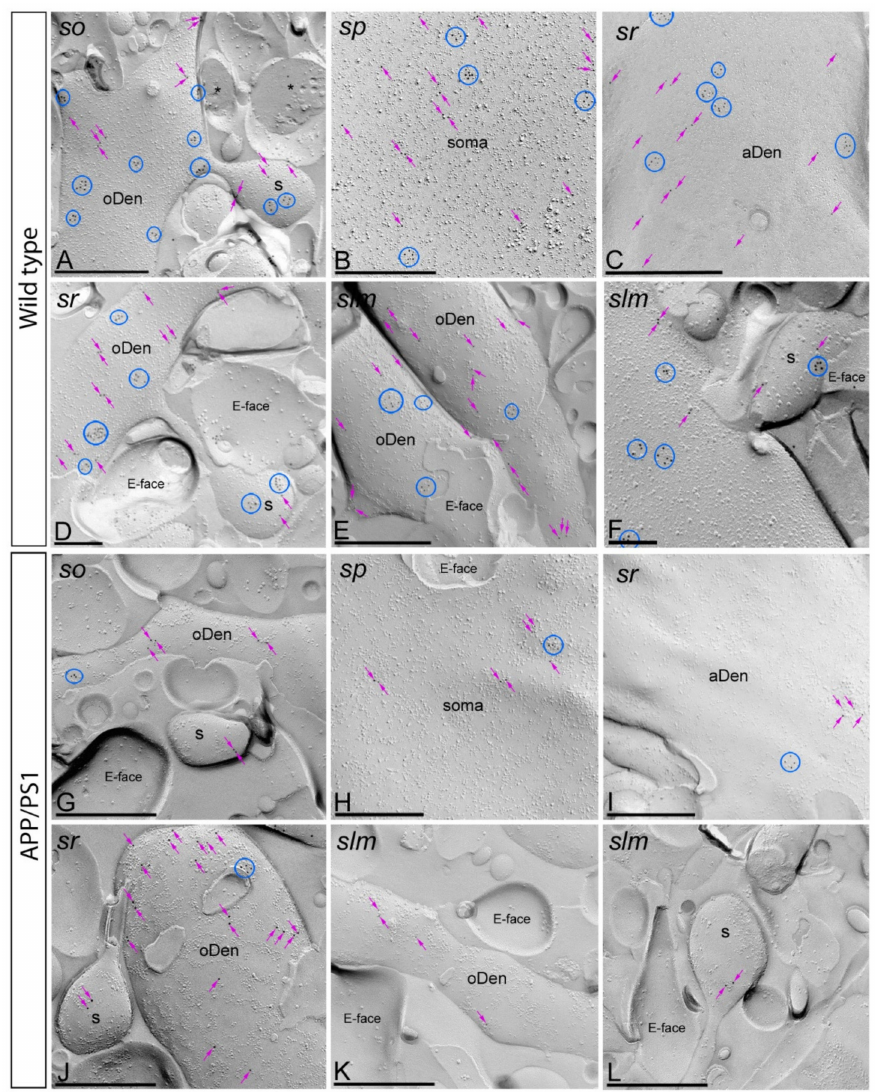
Figure 2. Subcellular localisation of mGlu 5 in somato-dendritic domains of CA1 pyramidal cells in wild type and APP/PS1 mice. ( A – F ) Electron micrographs obtained from different subfields of the CA1 region showing immunoparticles for mGlu 5 along the surface of pyramidal cells, as detected using the SDS-FRL technique in wild type mice at 12 months of age. Immunoparticles for mGlu 5 were detected forming clusters (blue circles) or scattered (purple arrows) associated with the P-face in the soma, apical dendrites (aDen), oblique dendrites (oDen) and dendritic spines (s) of CA1 pyramidal cells. Cross-fractures are indicated with asterisks (*). The E-face is free of mGlu 5 immunolabelling. ( G – L ) Electron micrographs obtained from different subfields of the CA1 region showing immunoparticles for mGlu 5 along the surface of pyramidal cells, as detected using the SDS-FRL technique in APP/PS1 mice at 12 months of age. Immunoparticles for mGlu 5 were detected, at low frequency, forming clusters (blue circles) or scattered (purple arrows) associated with the P-face in the soma, apical dendrites (aDen), oblique dendrites (oDen) and dendritic spines (s) of CA1 pyramidal cells. Cross-fractures are indicated with asterisks (*). The E-face is free of mGlu 5 immunolabelling. Abbreviations: so , stratum oriens ; sp , stratum pyramidale ; sr , stratum radiatum ; slm , stratum lacunosum-moleculare . Scale bars: ( A – C , E , G – L ) 0.5 µ m; ( D , F ), 0.2 µ